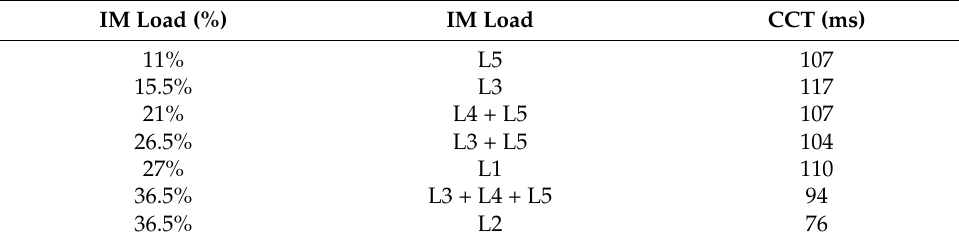
Table 6. Network fault critical clearance time vs. motor load percentage.